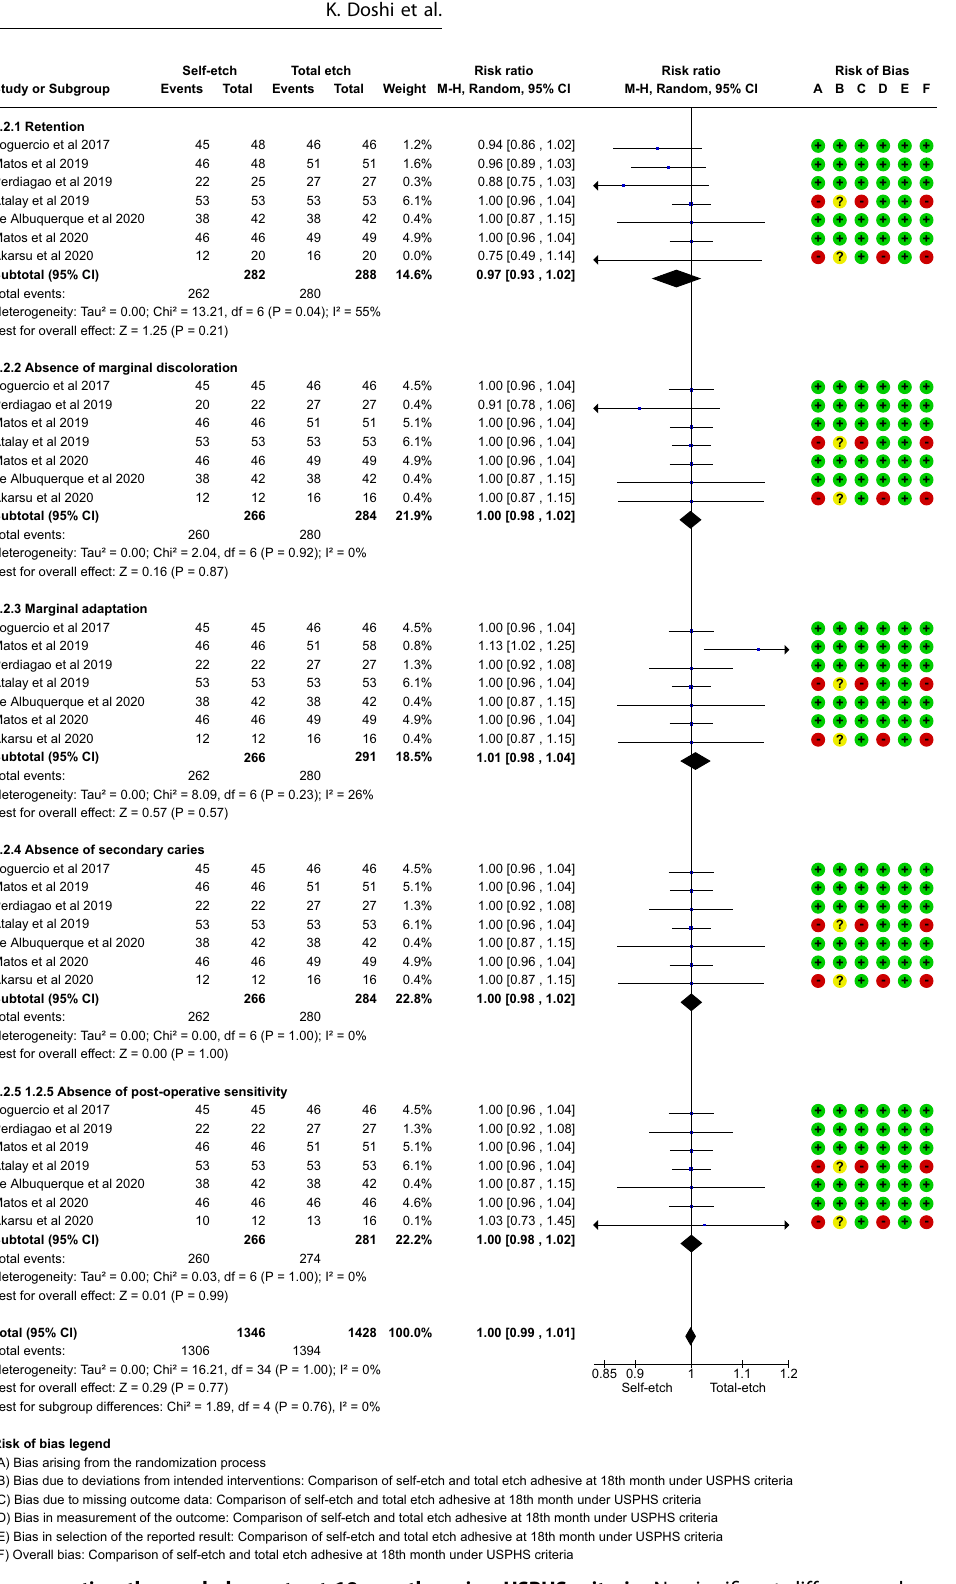
Fig. 6 Forest plot representing the pooled events at 18 months using USPHS criteria. No signi fi cant difference observed between total etch and self-etch adhesive strategies for any of the